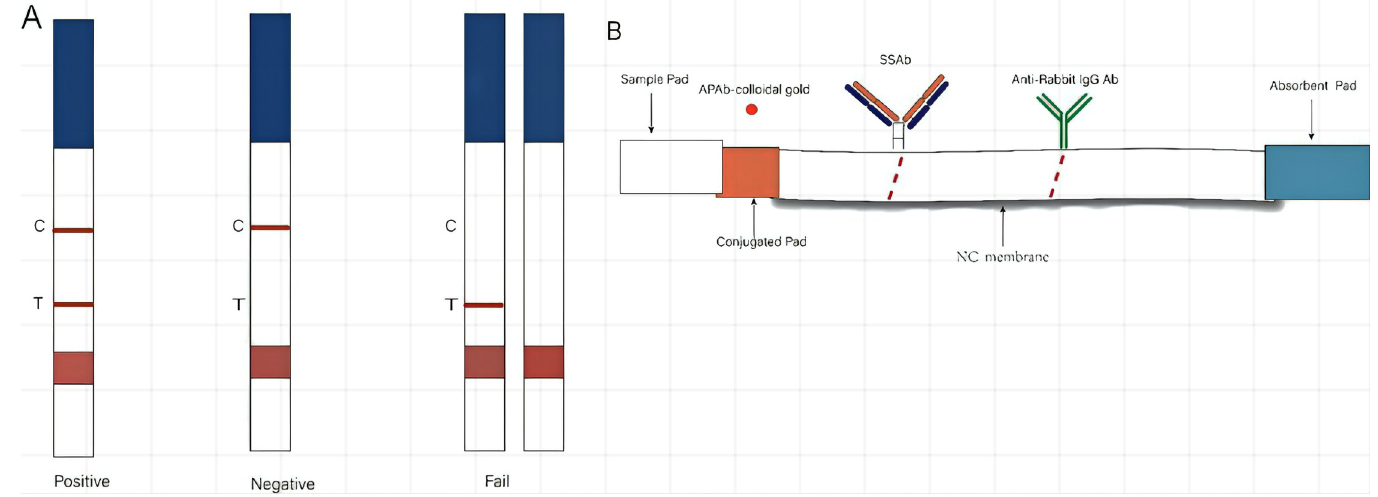
Fig 9. Schematic diagram of the LFA for detecting snake venom. (A) A schematic illustration of the predicted results is displayed. C, control line; T, test line; and (B) The design of the LFA strip constructed on the basis of IgG-conjugated colloidal gold and SSAb.